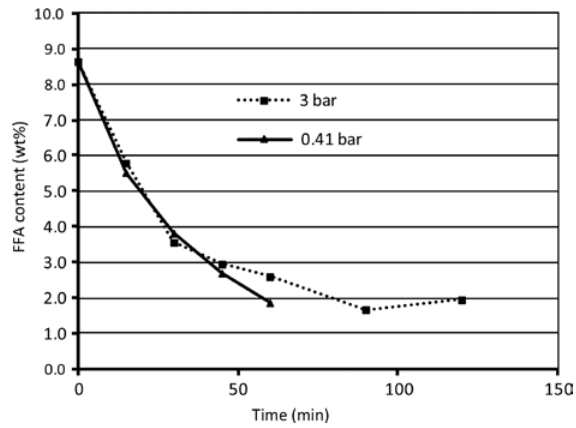
Figure 5: Influence of pressure on free fatty acid (FFA) reduction (T = 220 ° C, oil:glycerol mass ratio 6:1).